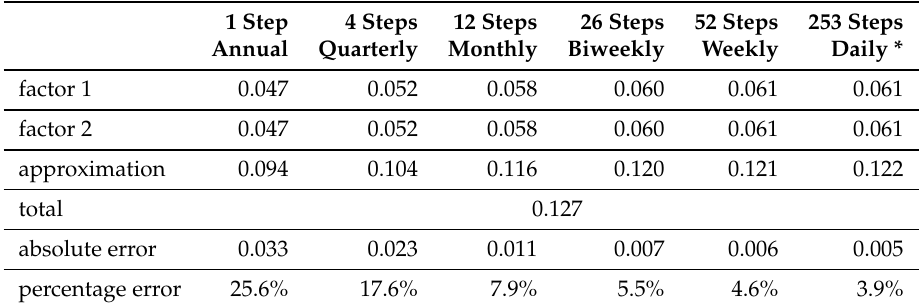
Figure 3. Risk attribution to two risk factors. In the upper panel with 26 time steps, the sum of the risk attribution matches much better the total risk than in the lower panel with only one time step. Table 3. Risk attribution to two risk factors. The approximation error is averaged over the weight of the first factor, and expected shortfall at 99.5% level is used as the risk